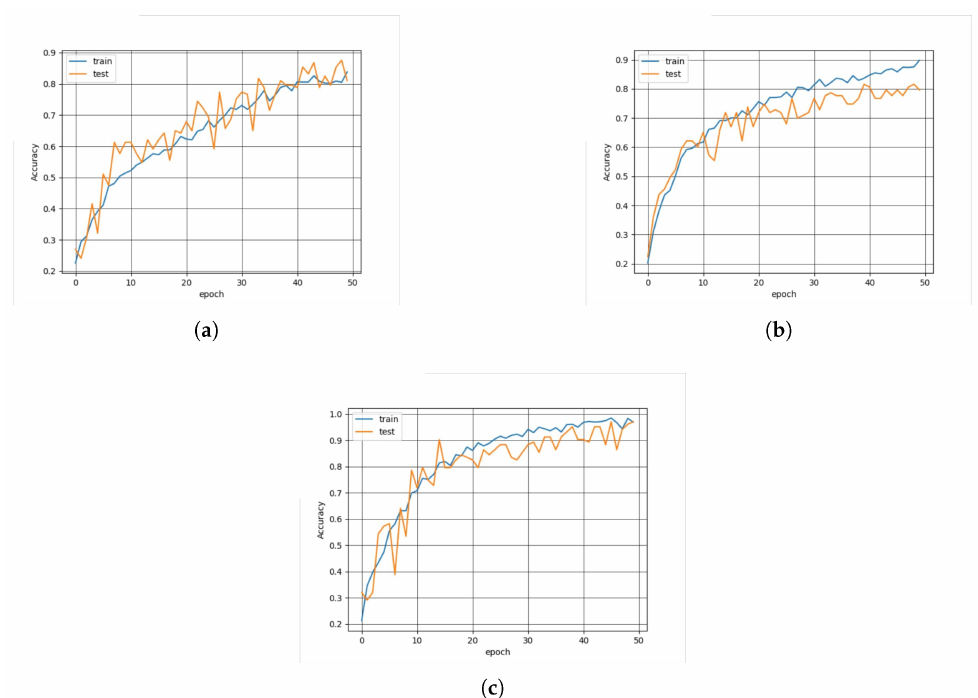
Figure 14. Interferometric spectrogram (left to right).